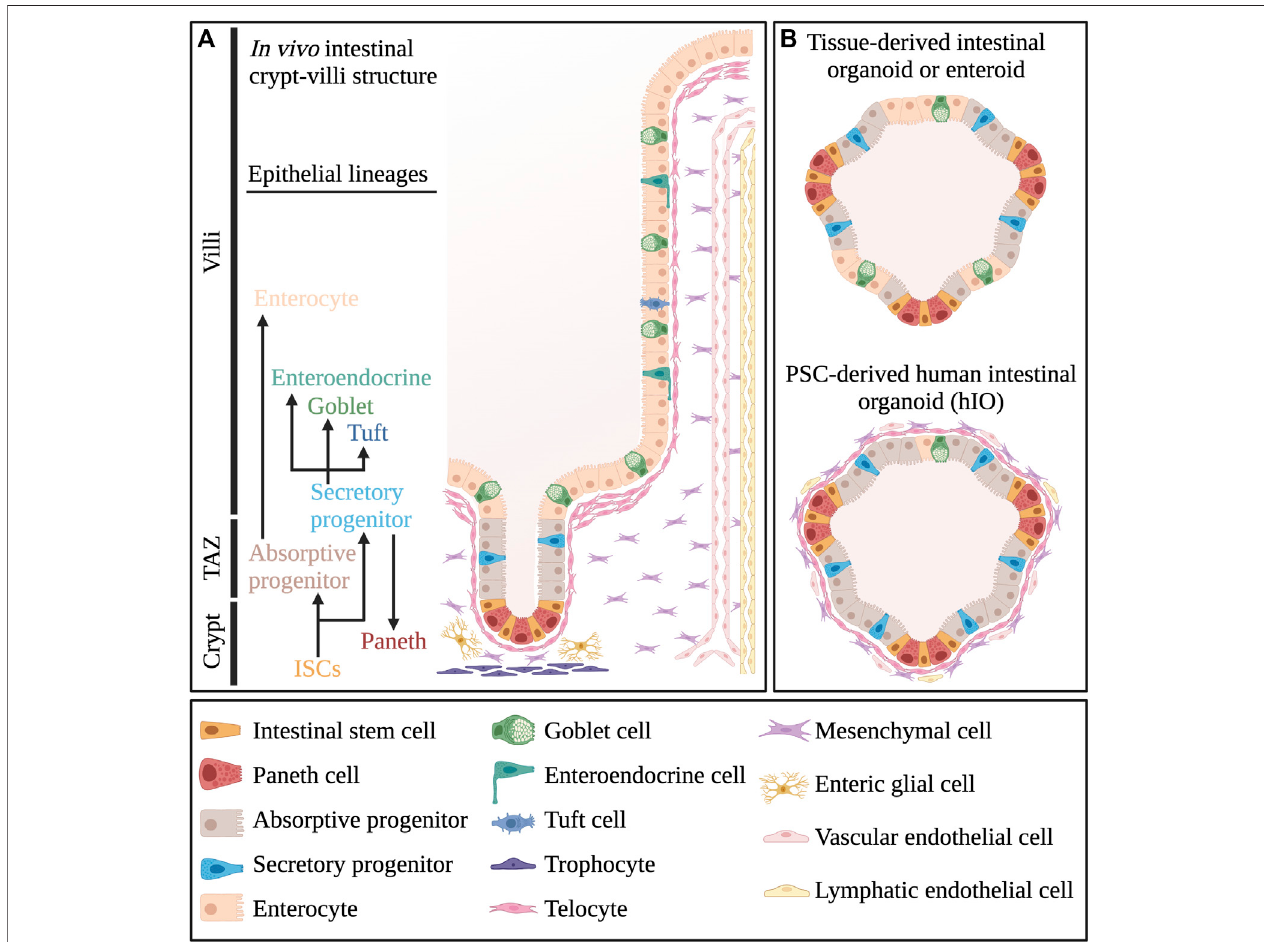
FIGURE 1 | Cellular composition of intestinal tissue and organoids. (A) Different cell types that make up the crypt-villi structure in vivo small intestinal tissue. (B) Comparative overview of the cellular composition of pluripotent stem cell-derived human intestinal organoids or hIOs and tissue-derived organoids or enteroids. TAZ, Transit Amplifying Zone. Created with